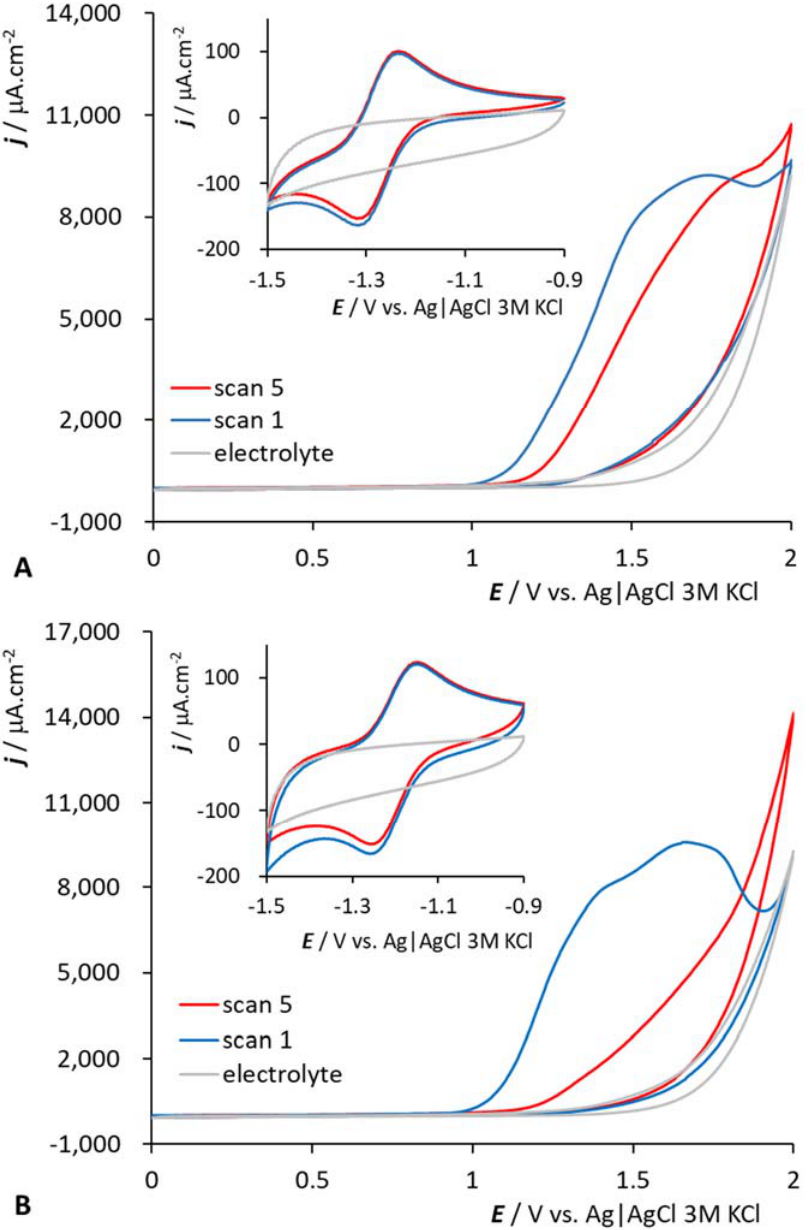
Figure 3. Cyclic voltammogram of HOOC-CoSAN ( A ) and (HOOC)2-CoSAN ( B ) in PB, 1000 µ M concentration, GCE, pH = 8, scan rate ν = 100 mV · s − 1 .